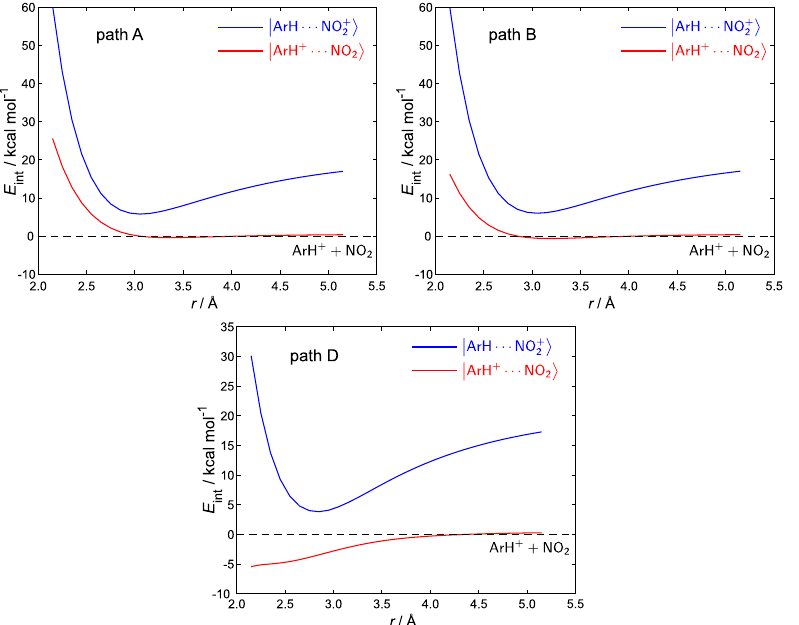
Figure 3. Predicted interaction energy of toluene/toluene + with NO + function of the distance of the interacting units, oriented as in the paths A, B, and D of Figure 1.